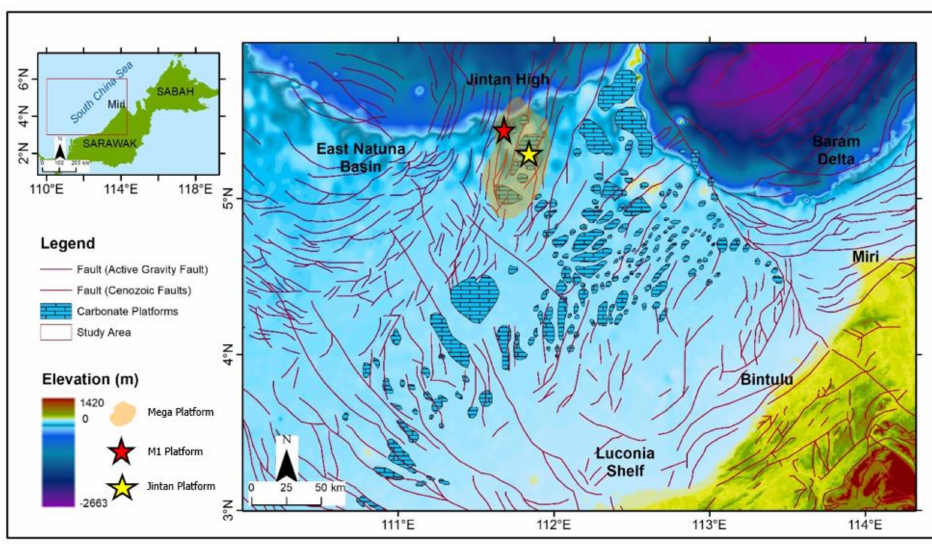
Figure 1. The location of Jintan and M1 platforms in Central Luconia province.